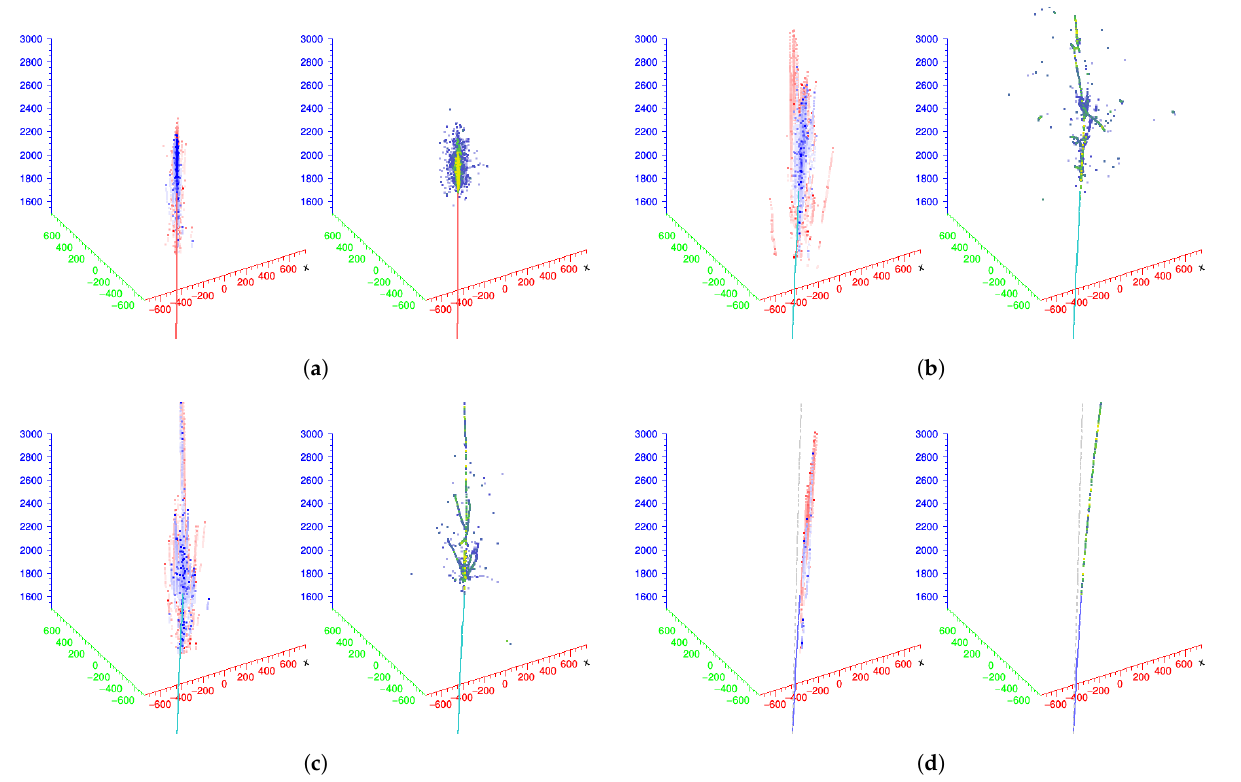
Figure 6. ( left ) Reconstructed and ( right ) MC truth 3D shower shapes of 20 GeV particles. For reconstructed cases, red dots represent the 3D hits from the scintillation channel and blue dots from the Cherenkov channel. The color code portrays the relative energy density for the MC truth case. E S , E C , and E DR indicate the reconstructed energy in GeV from the scintillation, Cherenkov channel, and the dual-readout corrected energy. The 2 T magnetic field was applied to all four cases. ( a ) Electron ( E S = 19.96, E C = 20.84). ( b ) Pion ( E S = 17.29, E C = 10.22, E DR = 20.04). ( c ) Punch-thru ( E S = 13.05, E C = 8.410, E DR = 14.85). ( d ) Muon ( E S = 1.550, E C =